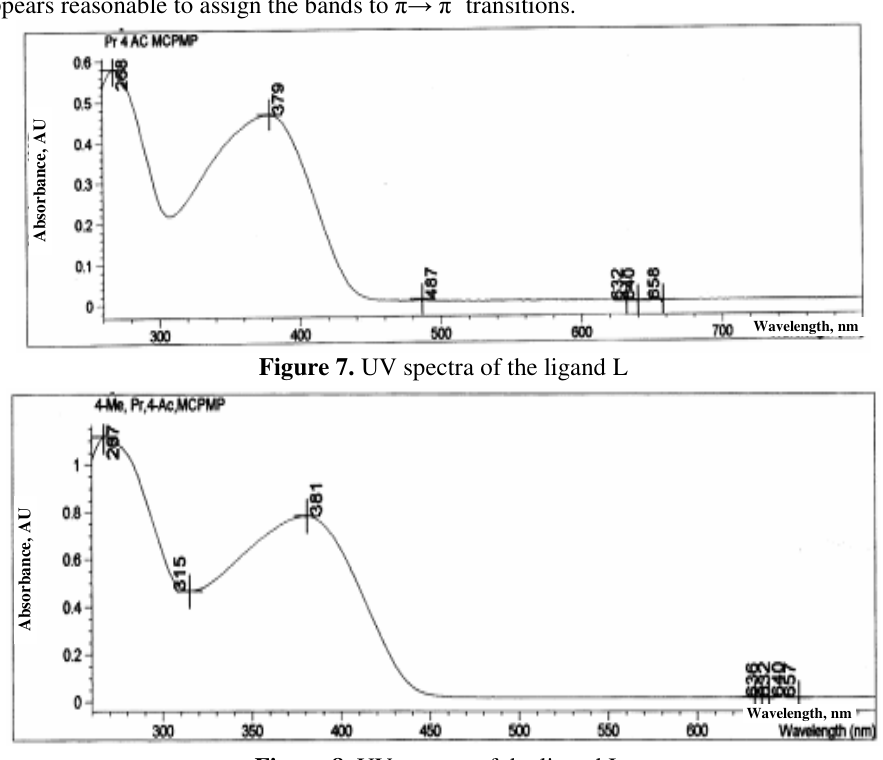
Figure 7. UV spectra of the ligand L